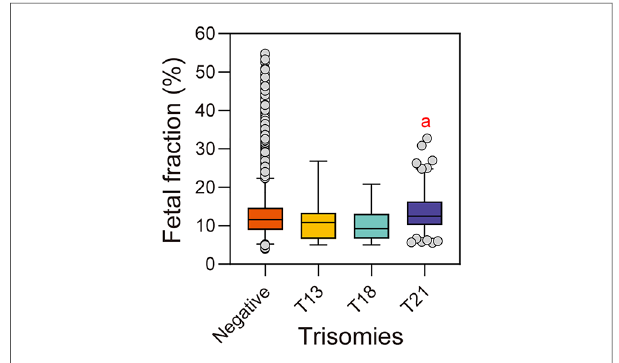
FIGURE 3 Fetal fraction of pregnant women with different types of trisomy fetuses. a Reference group is T18, P <0.05.